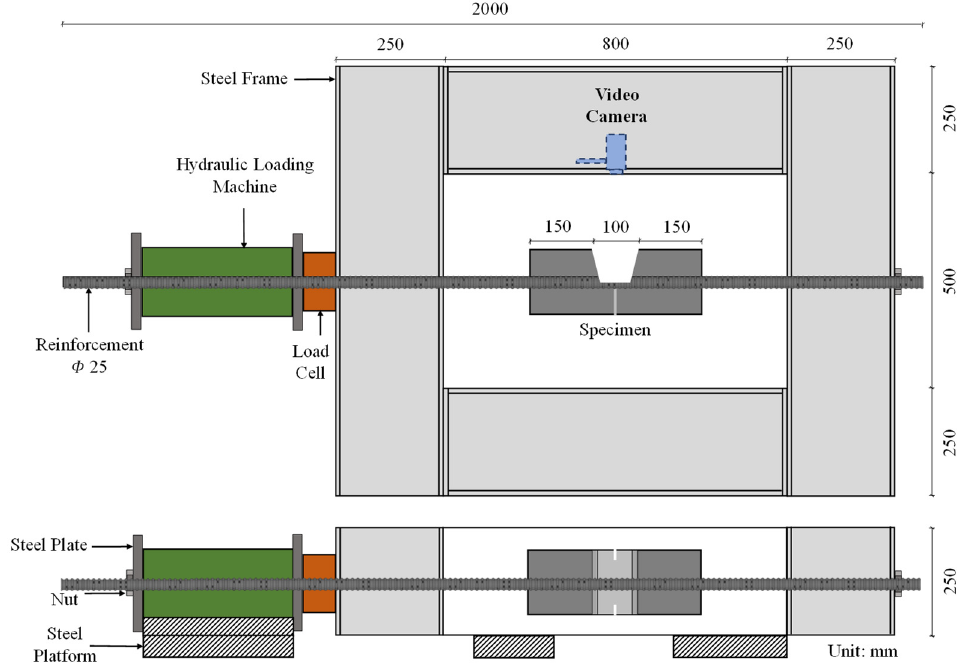
Figure 5. Experimental setup to conduct uniaxial loading test on the new specimen. Reprinted with permission from [32]. Copyright year 2021, Elsevier.